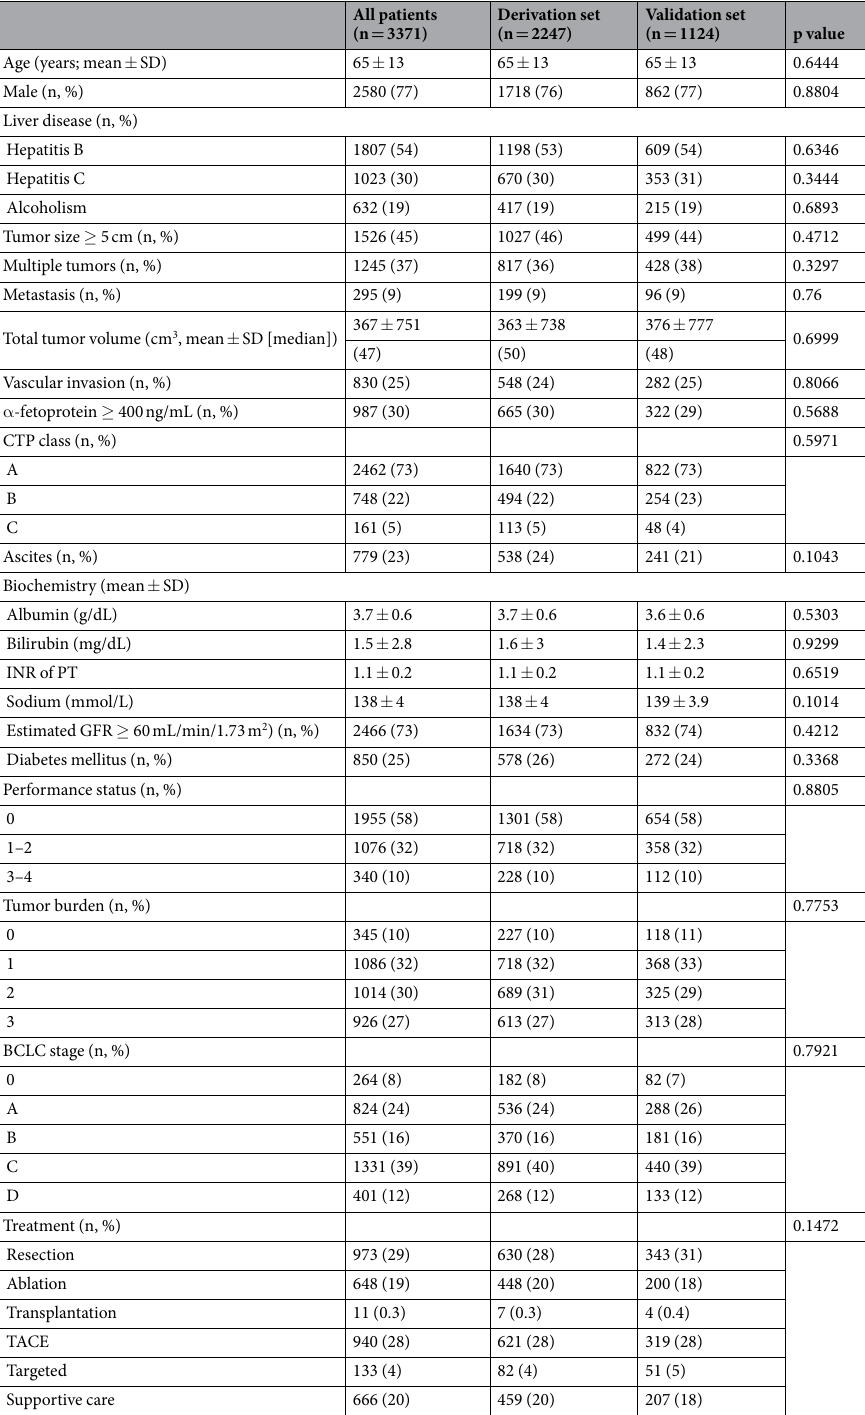
Table 1. Comparison of demographics of the derivation and validation sets. BCLC, Barcelona Clinic Liver Cancer; CTP, Child-Turcotte-Pugh; GFR, glomerular filtration rate; INR, international normalized ratio;